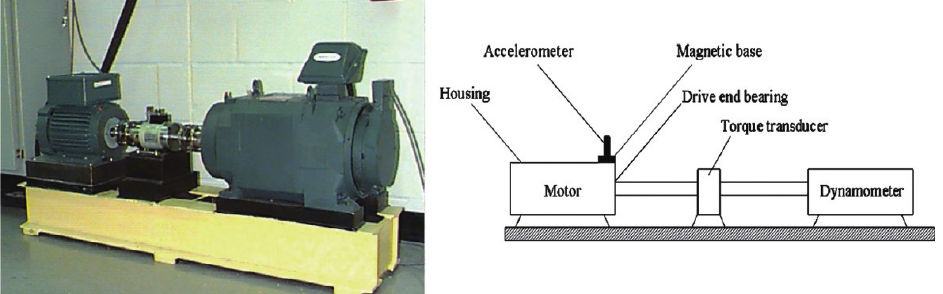
Fig. 1. Experiment system and its